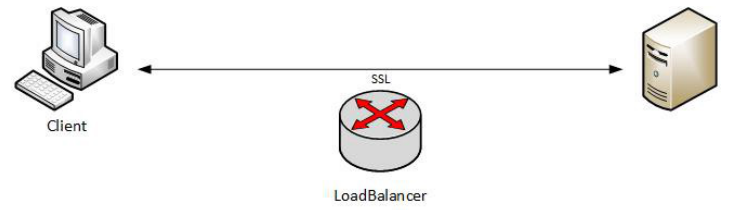
Figure 11. Mode TCP—Transparent